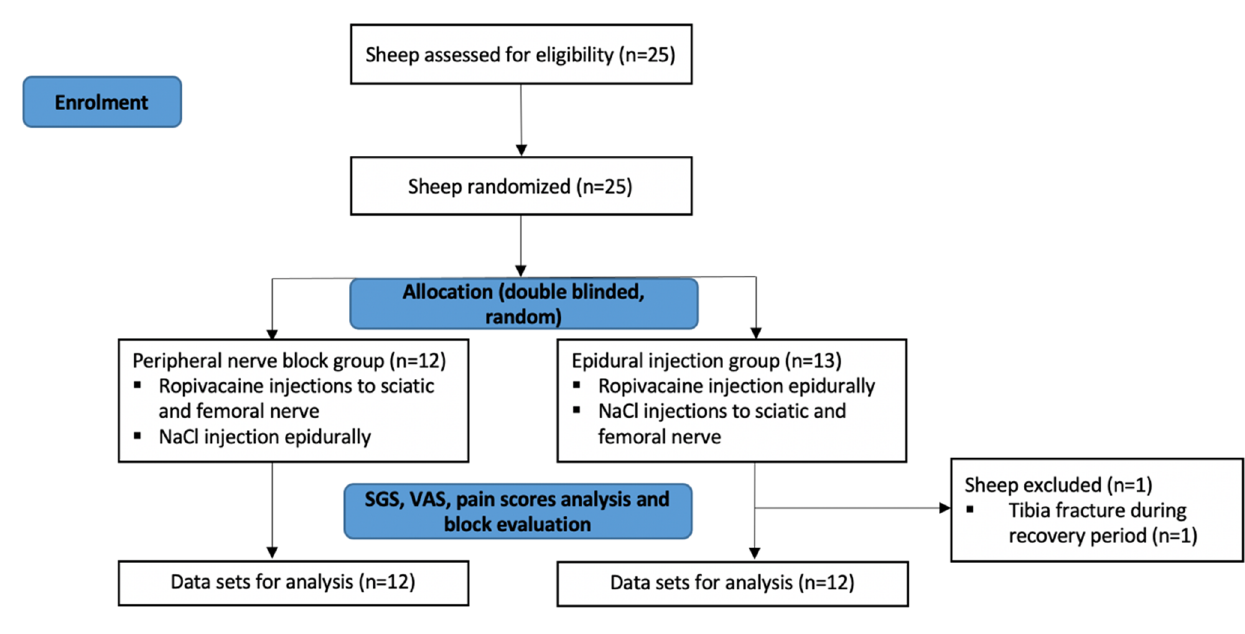
Figure 5. Flow diagram of sheep undergoing hind limp surgery eligible for the study in the time frame of February 2019 to August 2019. The diagram was adapted from CONSORT 2010 (transparent reporting of trials).